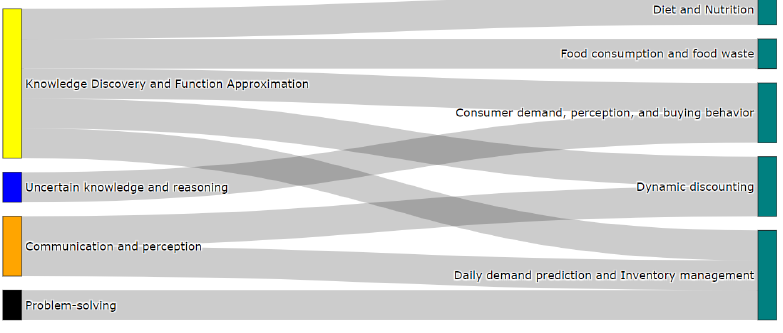
Figure 14. Retail problems classified by the proposed